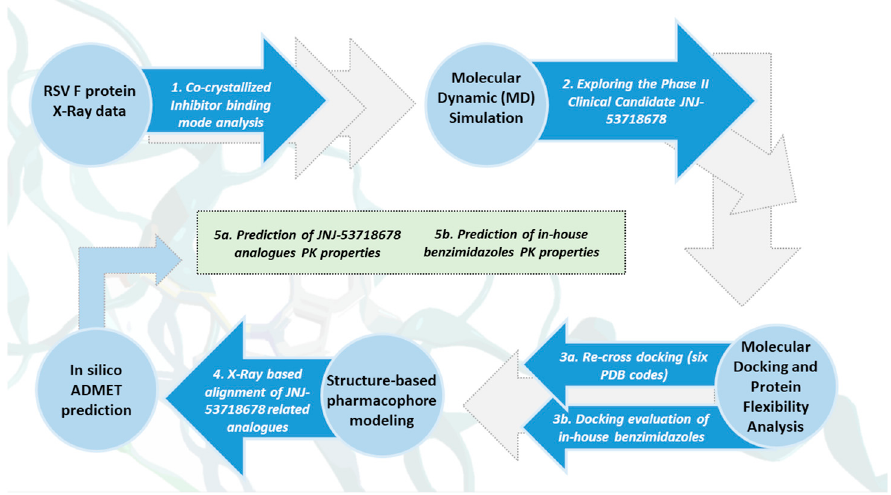
Figure 3. Scheme of the applied computational protocol including structure-based studies and in silico predictive tools.